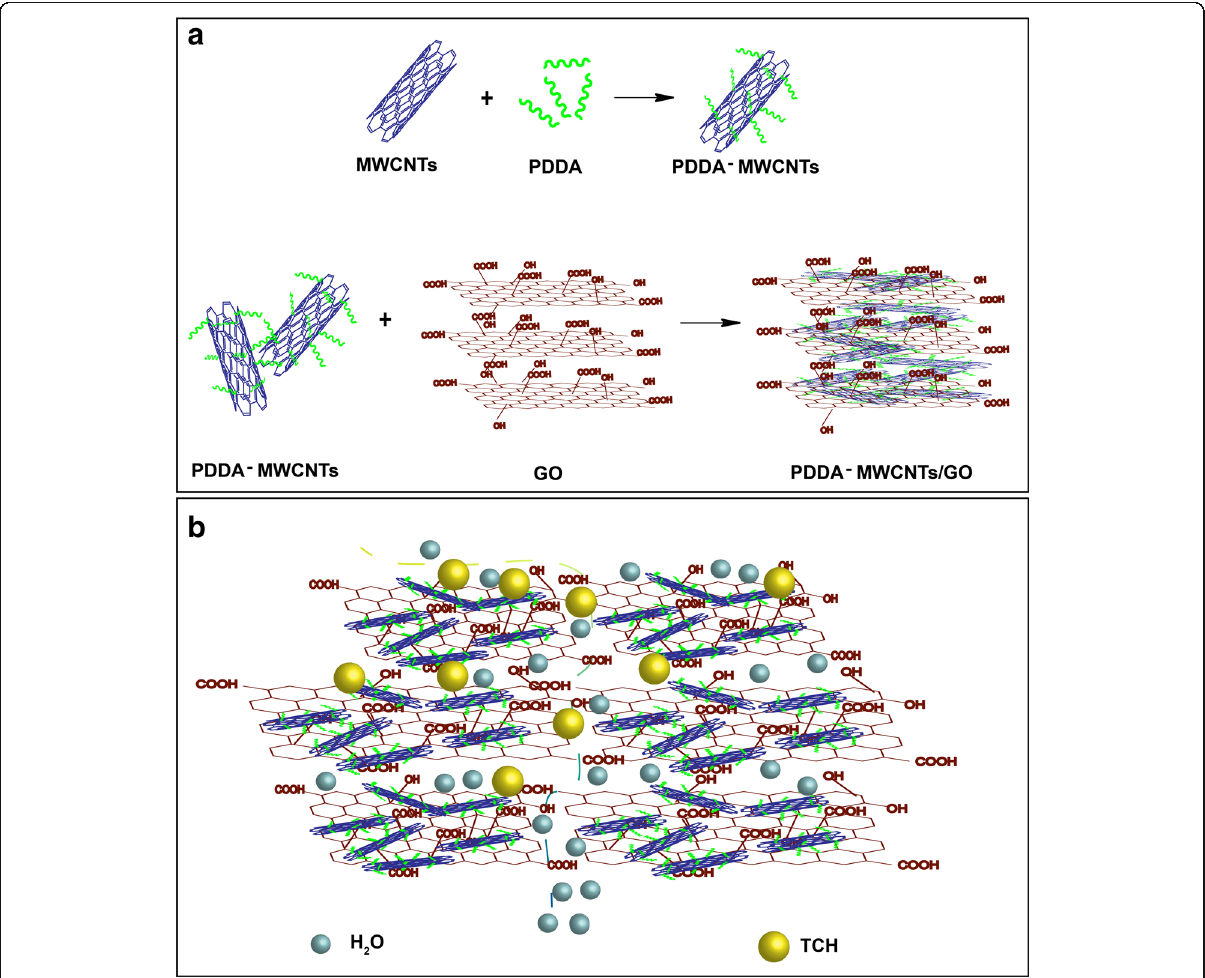
Fig. 1 a The constructed process for PDDA-MWCNTs/GO membrane. b The schematic of adsorption of antibiotics by PDDA-MWCNTs/GO